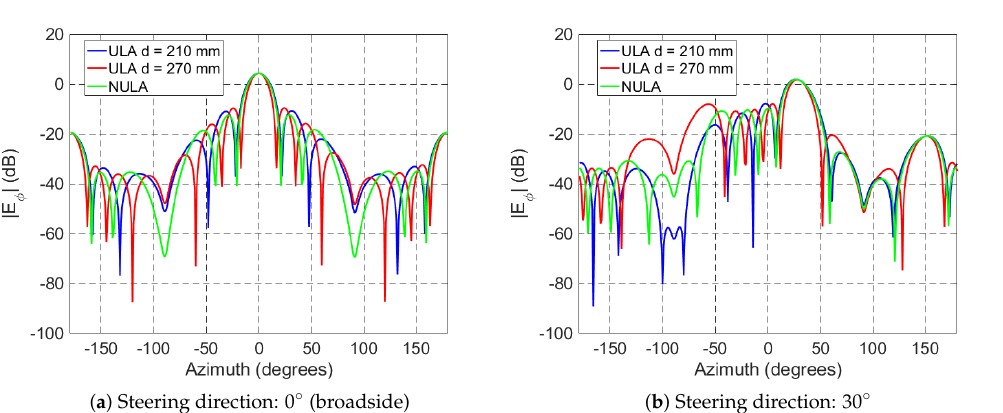
Figure 11. Azimuth plane radiation patterns of the ULAs ( d = 210 mm and 270 mm) and NULA, with five Televes 4G NOVA antennas without the radome or reflector, for 770 MHz.